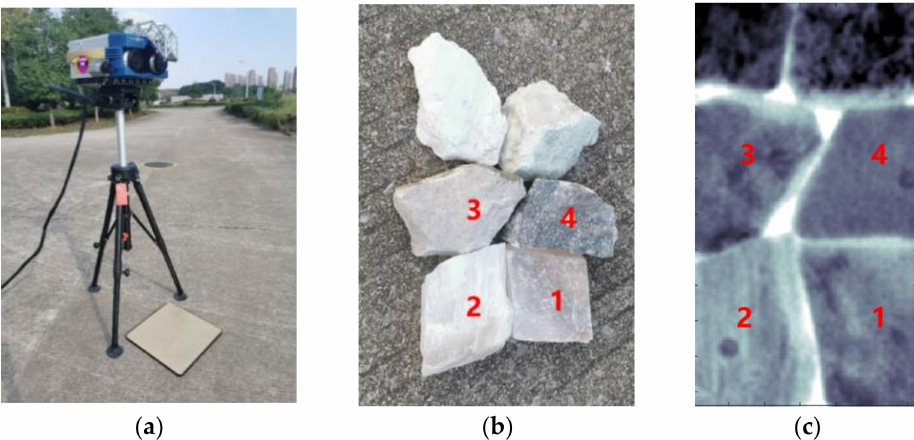
Figure 6. Field-based TIR hyperspectral imagery measurement scene and samples: ( a ) the field mea- surement scene and the Hyper-Cam LW sensor; ( b ) the used mineral samples; ( c ) the corresponding TIR